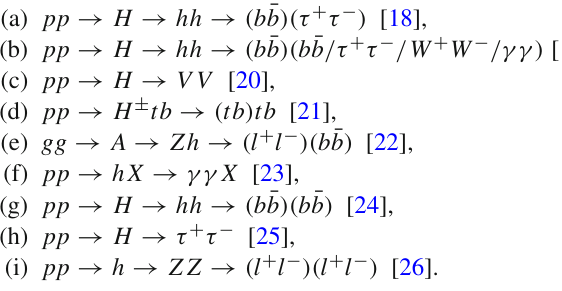
Fig. 6 Allowed regions of the 2HDM in the ( c β − α , tan β) plane from BSM Higgs bosons searches and direct measurements of the 125 GeV Higgs from HiggsBounds (blue regions) and HiggsSignals (yel- low regions) in scenario C with m H = m A = m H ± = 650 GeV for